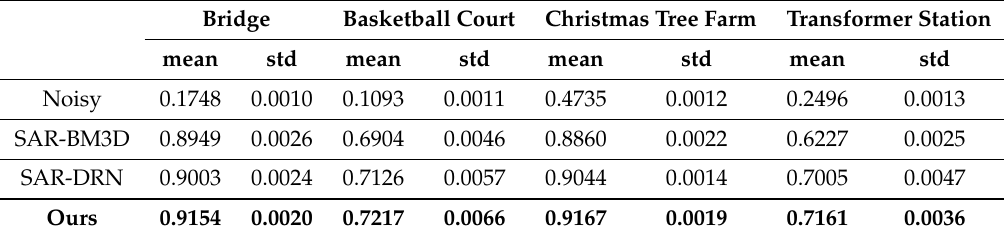
Table 2. SSIM computed on test set.